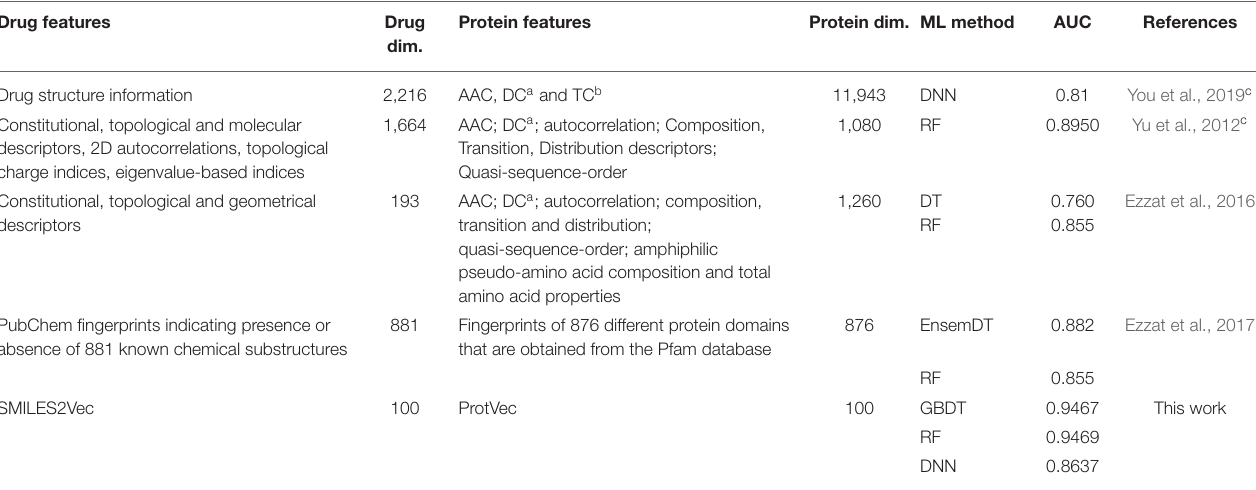
TABLE 3 | AUCs of SPVec and other models on DTI predictions using DrugBank. Drug